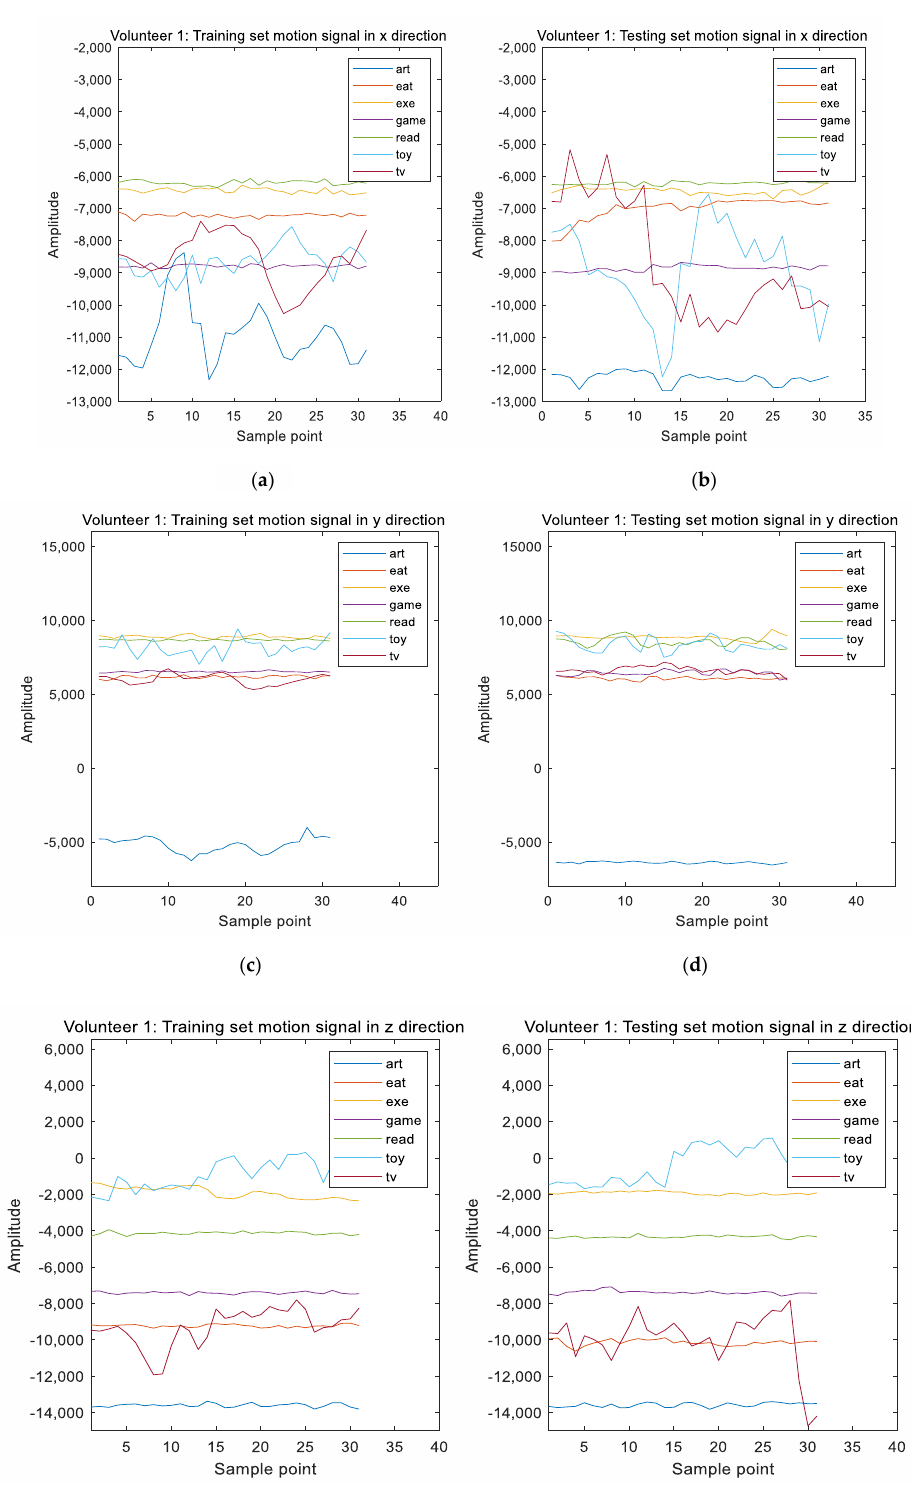
Figure 2. ( a ) The motion signal in the x-direction from the training set. ( b ) The motion signal in the x-direction from the testing set. ( c ) The motion signal in the y-direction from the training set. ( d ) The motion signal in the y-direction from the testing set. ( e ) The motion signal in the z-direction from the training set. ( f ) The motion signal in the z-direction from the testing set.